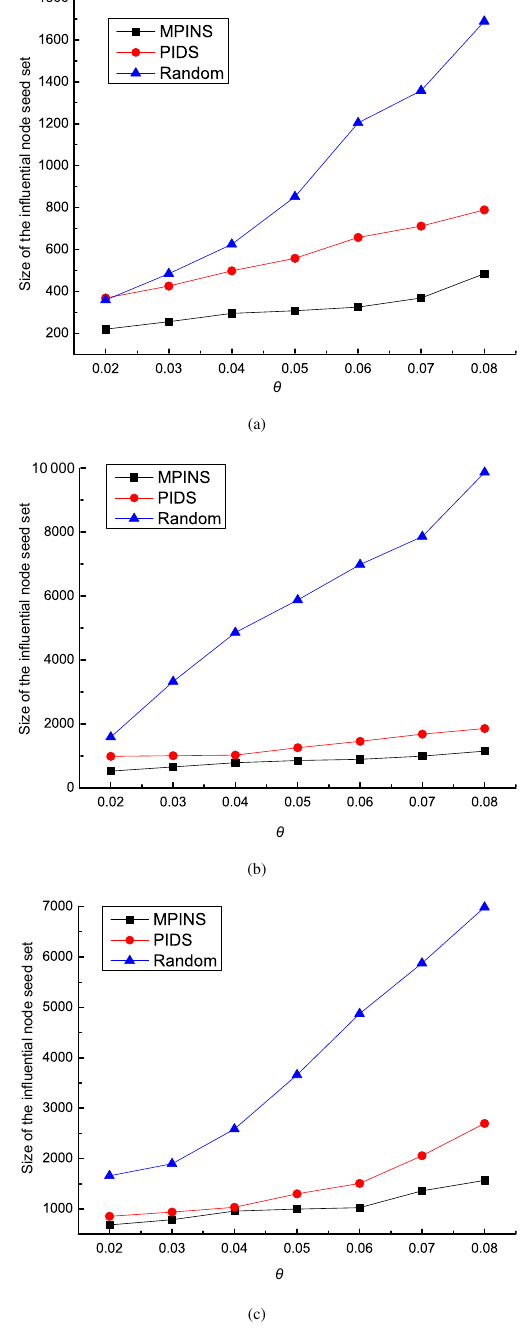
Fig. 14 MPINS vs. PIDS vs. Random in (a) WikiVote data set, (b) Coauthor data set, and (c) Twitter data